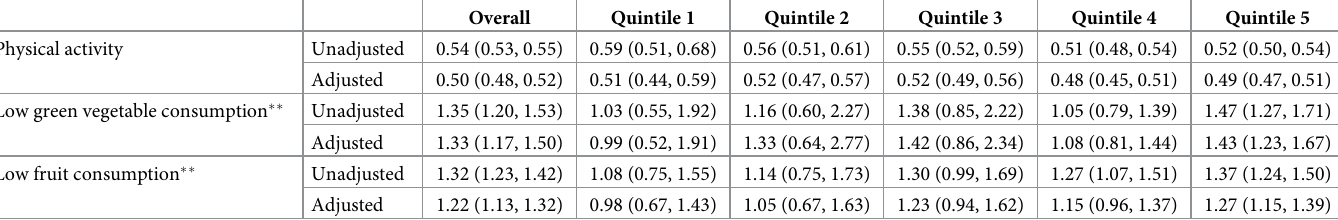
Table 4. Unadjusted and adjusted � odds ratios of obesity from physical activity, low vegetable consumption, and low fruit consumption overall and stratified by population density